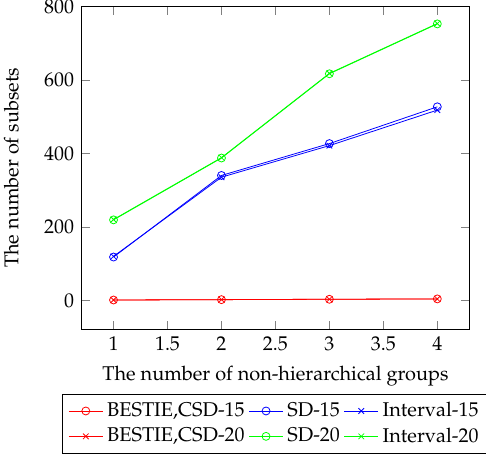
Figure 4. The number of subsets in the BESTIE, CSD, SD, and interval schemes for secure multicast